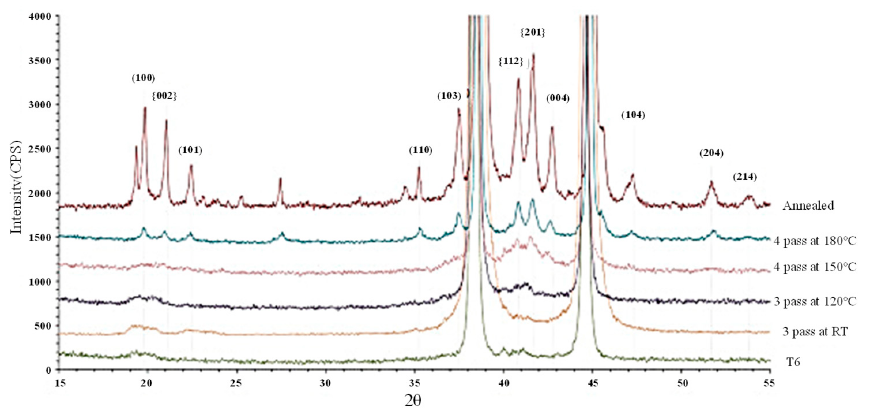
Figure 22. XRD patterns after ECAP treatment at different temperatures [133]. Reproduced with permission from Elsevier B.V.